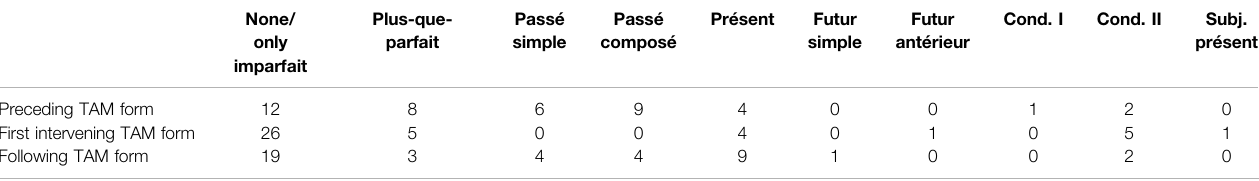
TABLE 6 | TAM forms related to the imparfait chains in Emolex (for a total of 42 texts).